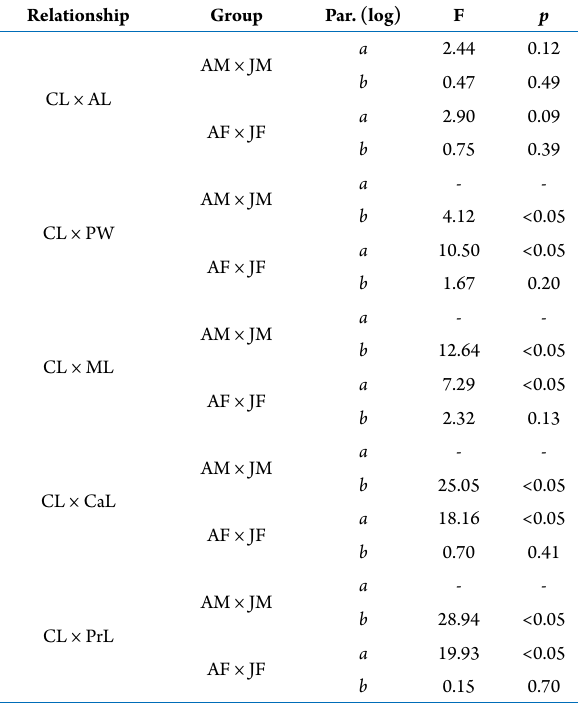
Table 1. Macrobrachium candango Mantelatto, Pileggi, Pantaleão, Magalhães, Villalobos and Álvarez, 2021. Results of covariance analyses (ANCOVA) with morphometric data. AM: adult males; JM: juvenile males, AF: adult females; JF: juvenile females; CL: